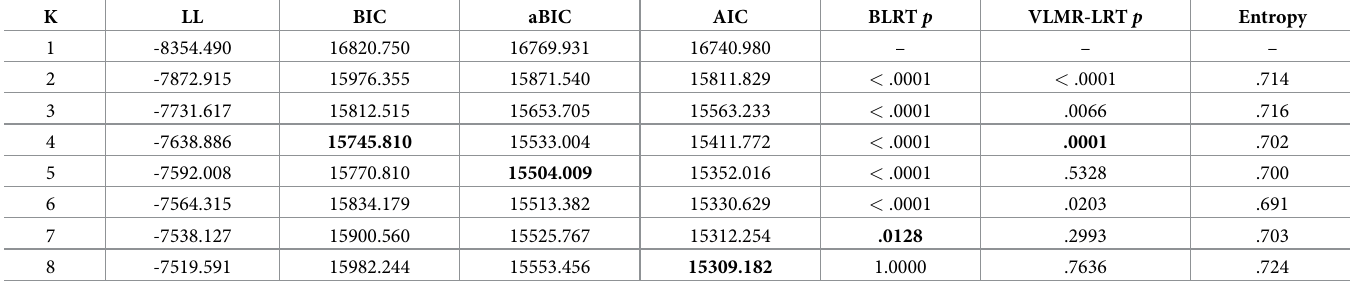
Table 3. LCA fit indices.